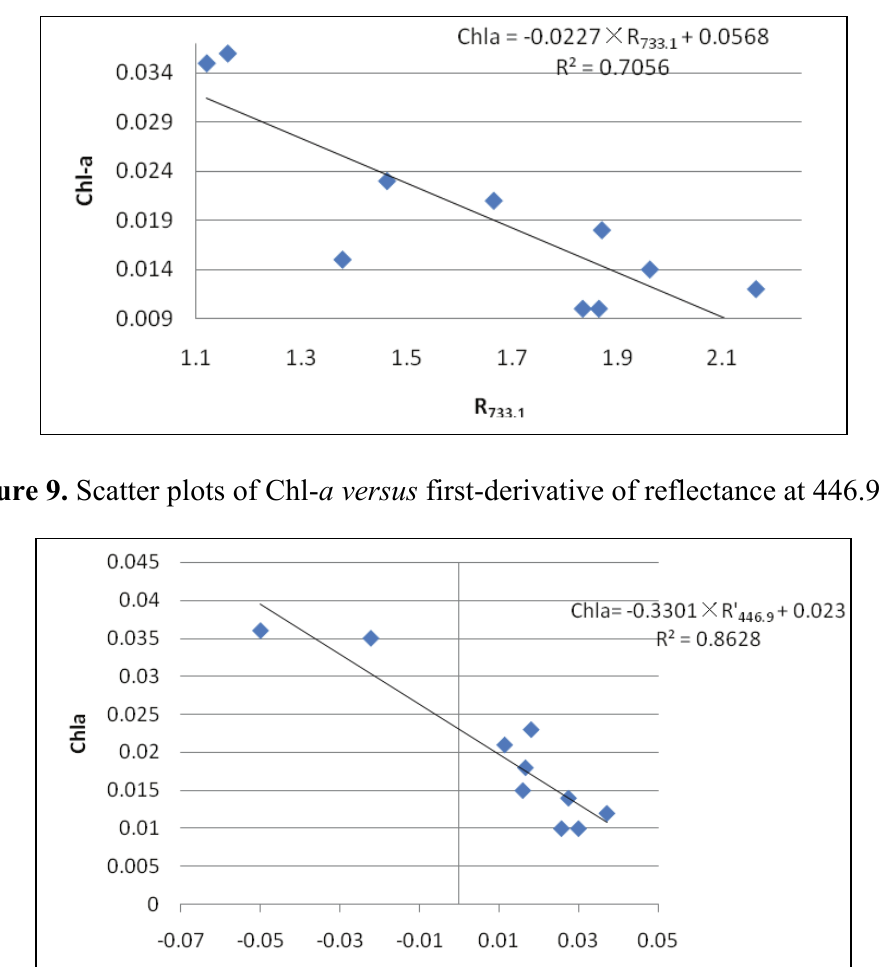
Figure 8. Scatter plots of Chl- a versus reflectance at 733.1 nm.